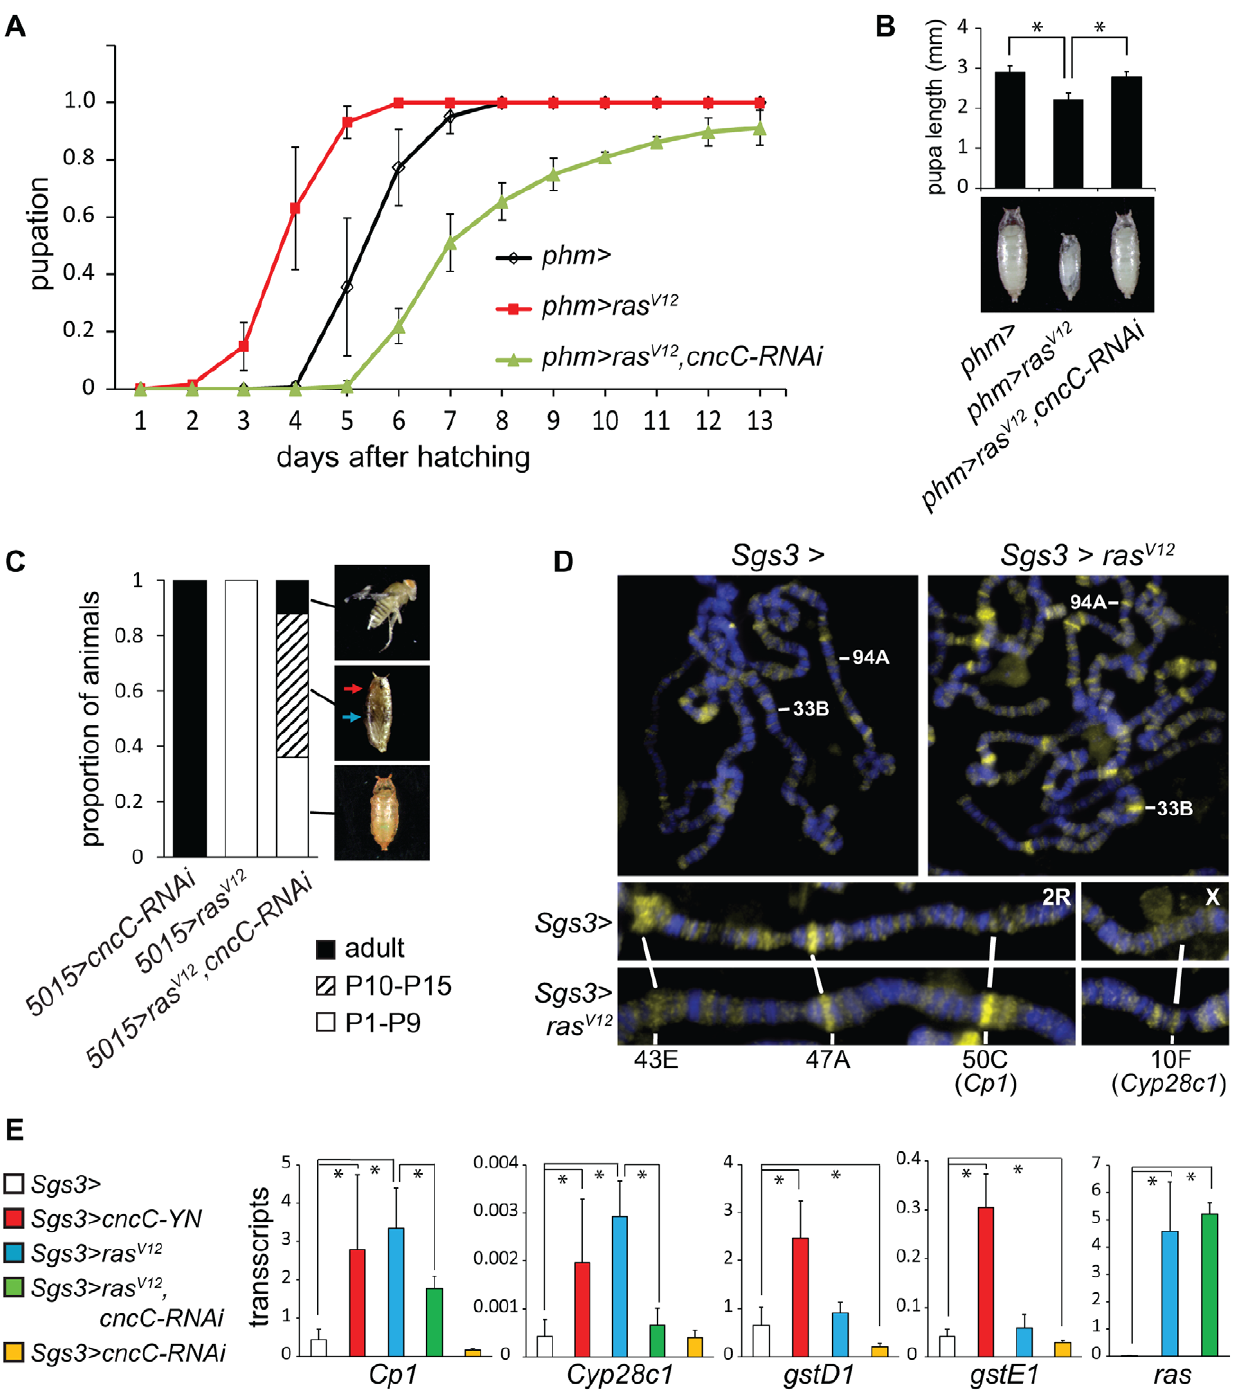
Figure 5. Interrelationships between Ras signaling and CncC functions. (A). Effects of CncC depletion on the time of pupation by larvae that expressed Ras V12 in the PG. The proportion of larvae that had formed pupae was plotted as a function of the time after hatching for control larvae ( phm . , black), larvae that expressed either Ras V12 alone ( phm . ras V12 , red) or Ras V12 together with the shRNA targeting CncC ( phm . ras V12 , cncC- RNAi , green) in the PG. The data represent the means and standard deviations from three repeats using 20–30 larvae in each. (B). Effects of CncC depletion on the sizes of pupae formed by larvae that expressed Ras V12 in the PG. The lengths of pupae formed by the larvae described in part A were measured. The data represent the means and standard deviations of 30 pupae of each genotype (*, p , 0.001). (C). Effects of CncC depletion and Ras V12 expression in the PG on pupal development. The terminal stage of development was recorded for pupae formed by larvae that expressed either the shRNA targeting CncC alone ( 5015 . cncC-RNAi ), Ras V12 alone ( 5015 . ras V12 ), or Ras V12 in combination with the shRNA targeting CncC ( 5015 . ras V12 , cncC-RNAi ) in the PG. The proportion of pupae that arrested at early (P1–P9, open bar) and late (P10–P15, striped bar) pupal stages and that eclosed (adult, solid bar) are indicated (images shown on the right). Early and late stage pupae were distinguished by the absence or presence of red eye pigment (red arrow) and dark wings (blue arrow). Approximately 100 animals of each genotype were scored. (D). Effects of Ras V12 expression in salivary glands on CncC occupancy on polytene chromosomes. Polytene chromosomes from control larvae ( Sgs3 . ) and larvae that expressed